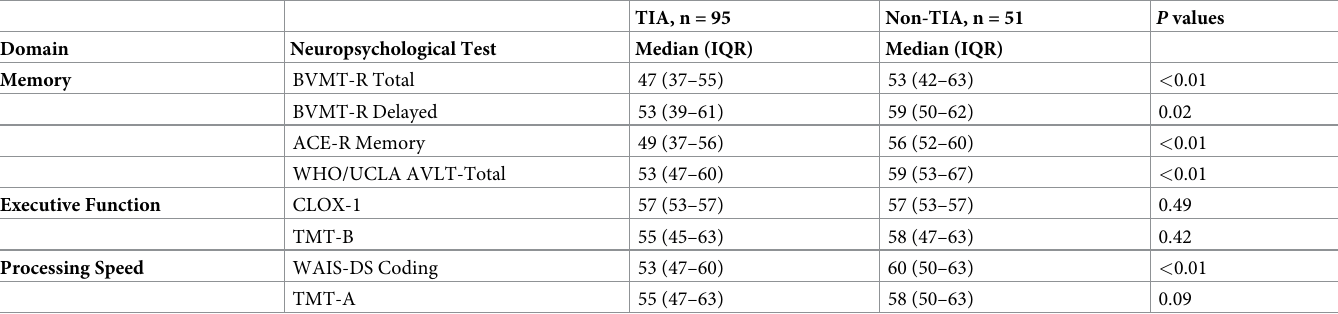
Table 2. Descriptive statistics and Wilcoxon rank-sum test for cognitive domains and neuropsychological tests for PREVENT subjects.